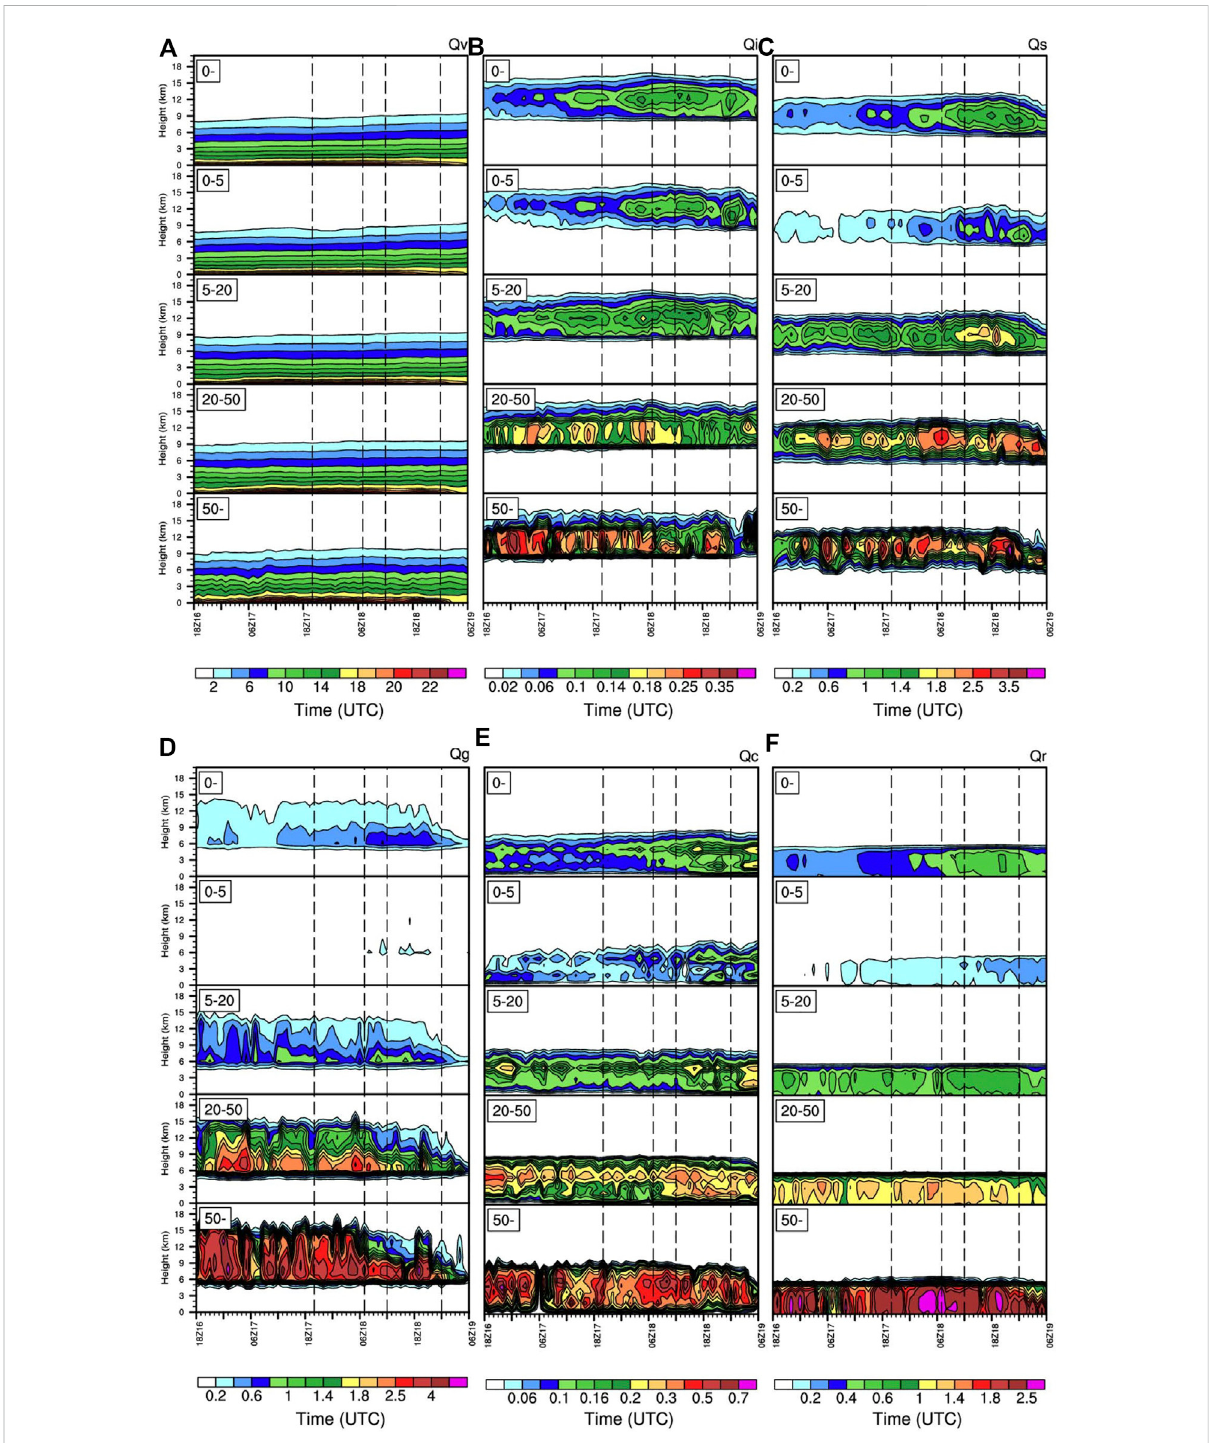
FIGURE 7 It is similar to Figure 6, but for the mixing ratio of (A) water vapor, (B) cloud ice, (C) snow, (D) graupel, (E) cloud water, and (F) rain water (unit: g Kg − 1